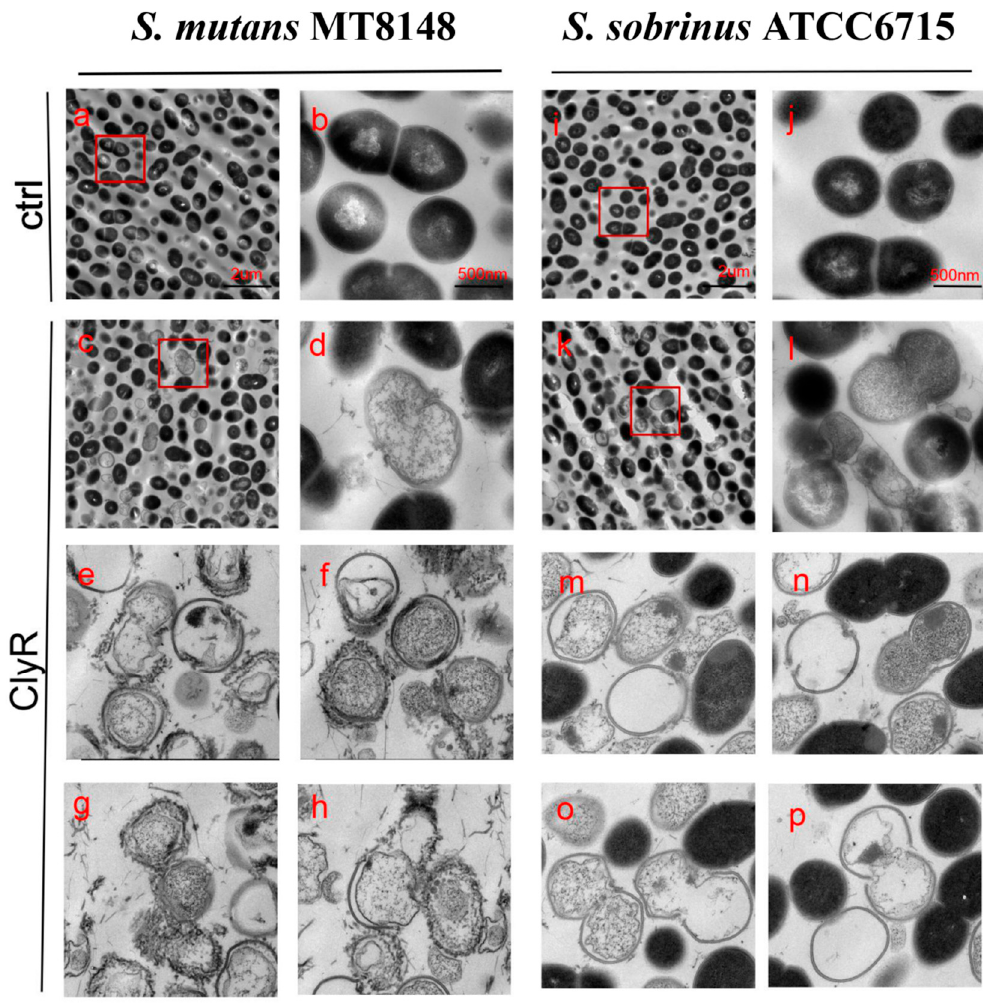
Figure 3. TEM images of S. mutans and S. sobrinus exposed to ClyR. Bacterial cells were treated with PBS (Ctrl, a , b , i , j ) or 50 µg/mL of ClyR ( c – h , k – p ) at 37 °C for 5 min and then fixed by 2.5% glutaraldehyde.